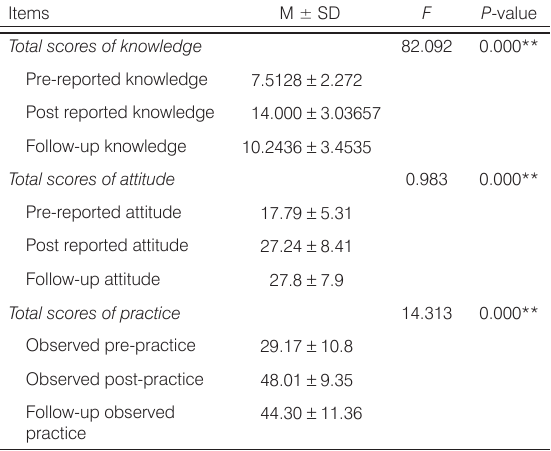
Table 3. Mean and standard deviation of total scores of reported caregivers’ knowledge, attitude, and observed practice regarding PU prevention throughout the training program ( n = Table 4 indicated a statistically positive correlation